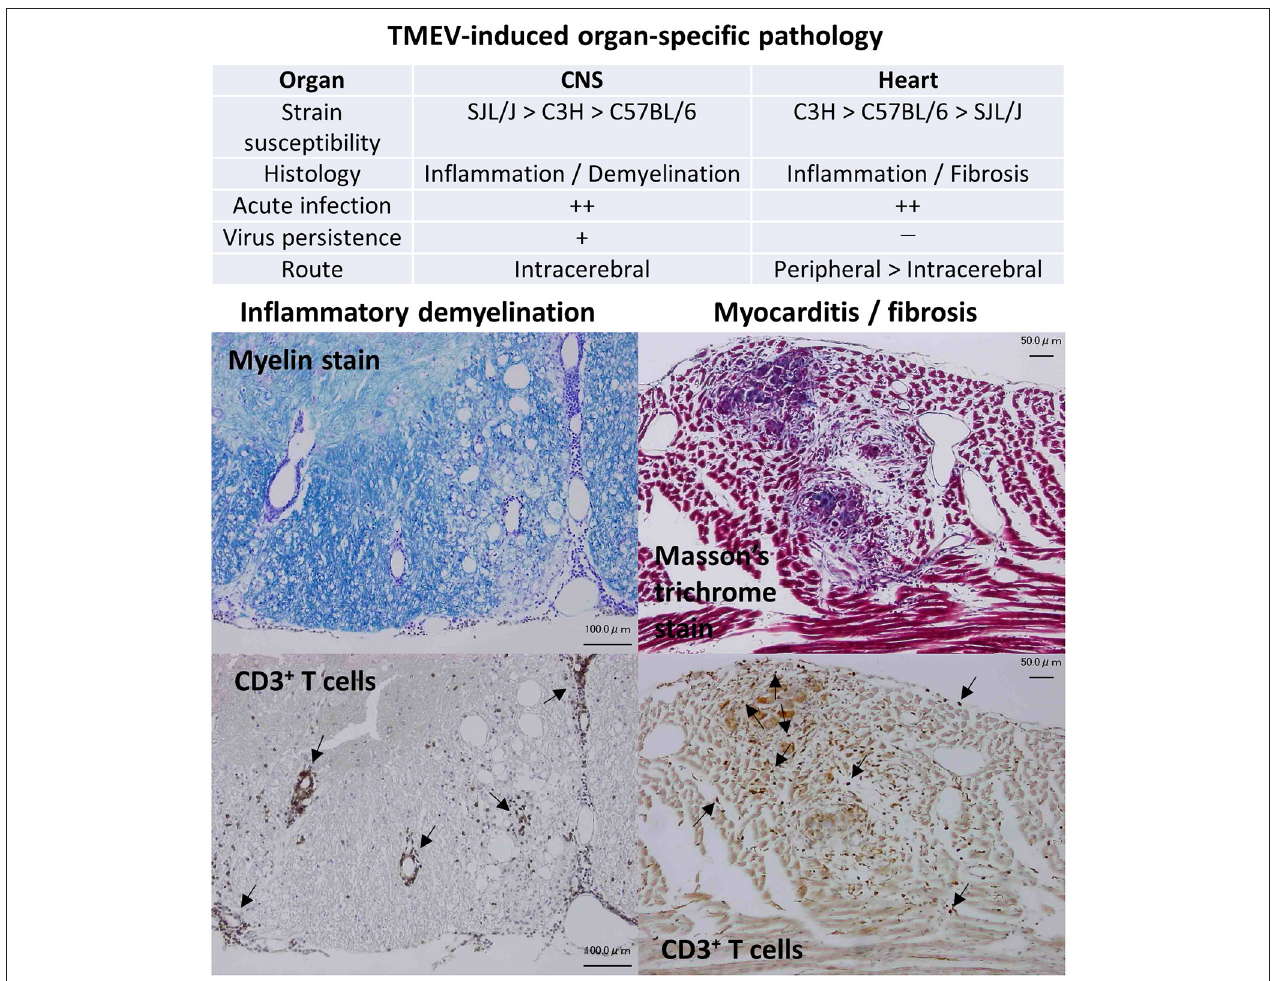
FIGURE 1 | Organ-specific pathology induced by Theiler’s murine encephalomyelitis virus (TMEV). TMEV induces pathology in two organs: inflammatory demyelination in the central nervous system (CNS) and inflammation followed with fibrosis in the heart, whose susceptibilities differ among mouse strains ( 9, 10). Although TMEV can infect the CNS and the heart during the acute phase, persistent viral infection is observed only in the CNS. CNS disease can be induced only by intracerebral inoculation. On the other hand, both peripheral and intracerebral routes of viral inoculation result in myocarditis, while peripheral inoculation induces more severe cardiac disease. ( Left ) Inflammatory demyelination in the spinal cord of TMEV-induced demyelinating disease (TMEV-IDD). Luxol fast blue stain. CD3 immunohistochemical staining of consecutive sections showed that T cells were present in perivascular cuffing and meningitis (Arrows). Bar: 100 µ m ( Right ) Inflammation and fibrosis in the heart during phase III of TMEV-induced myocarditis. Masson’s trichrome stain. CD3 immunohistochemical staining showed T cell infiltration (Arrows) in the heart. Bar: 50 µ